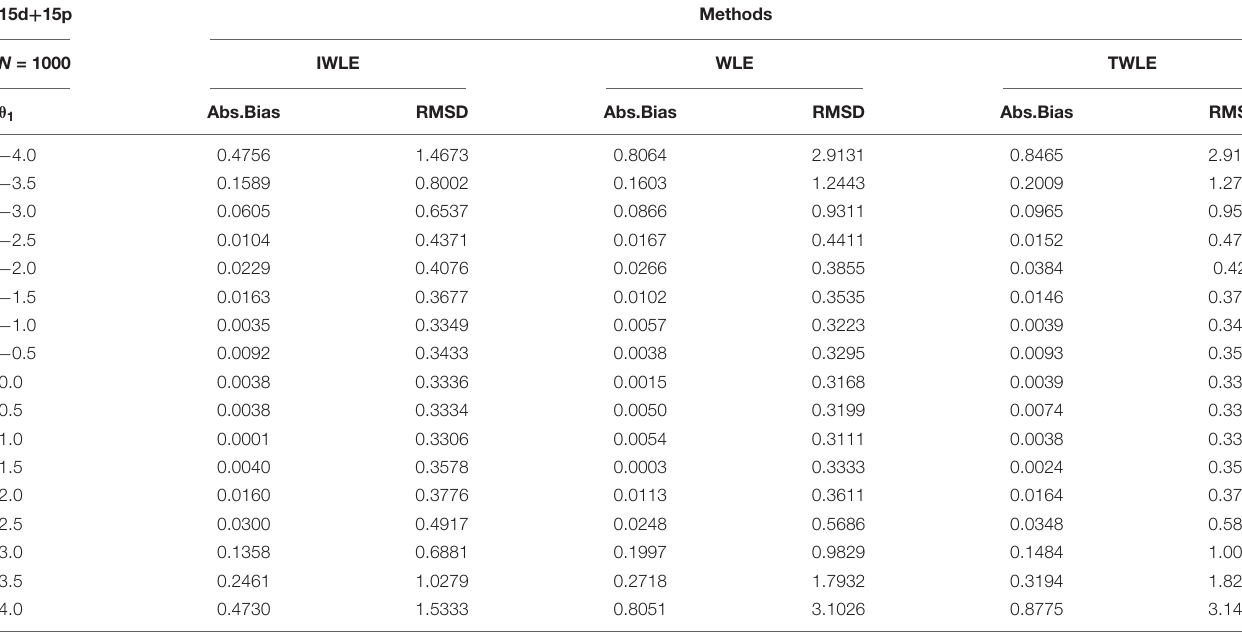
TABLE 4 | Absolute bias and root mean squared difference for WLE, TWLE, and IWLE at 17 different levels of initial ability on 15d + 15p.